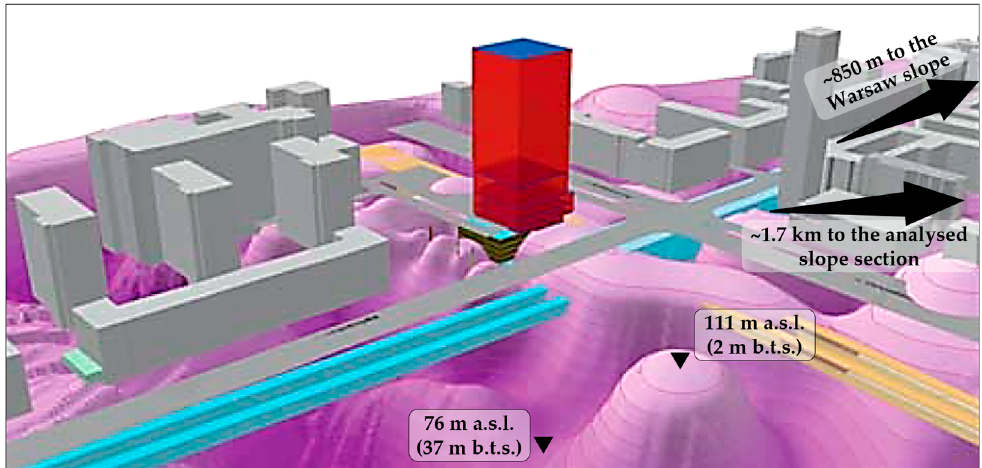
Figure 1. The Neogene clay roof within the Warsaw city centre (excluding soils lying over clay), modified from